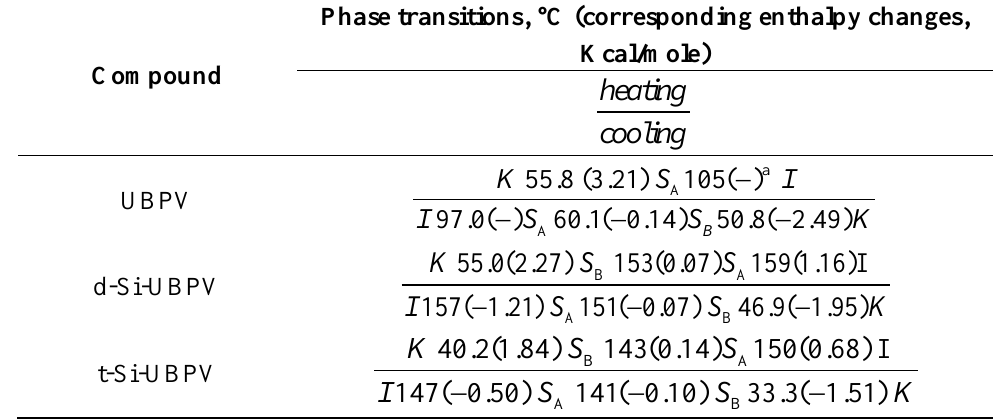
Figure 2. Polarizing optical micrographs (magnification × 320) of compound d-Si-UBPV in ( A ) S texture obtained after cooling from isotropic phase to 155 °C and ( B ) S A texture obtained after cooling to 151 °C; ( C ) S